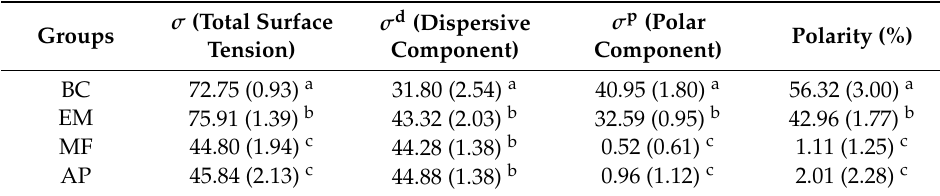
Table 2. Mean values (standard deviations) of surface energy parameters in mN/m for the four sealers ( n = 12).